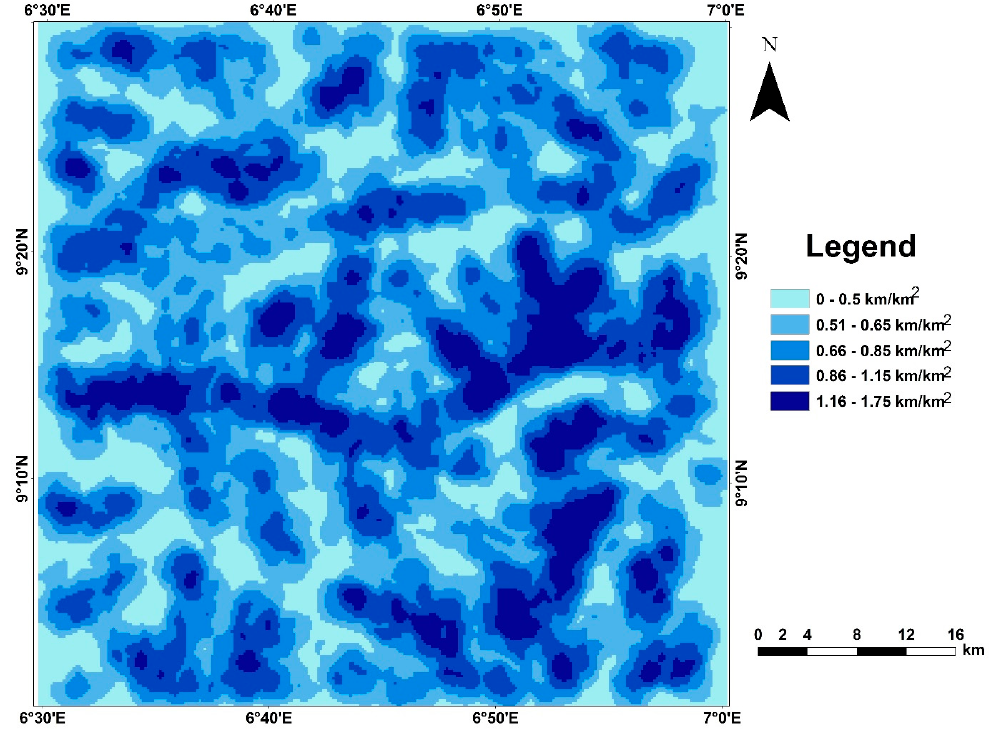
Figure 3. Drainage networks density of Paiko Sheet 185 North Central Nigeria produced from drainage networks extracted from SRTM DEM using density tool of ArcGIS. Areas having lighter shades represent areas of low drainage densities. Drainage density values are inversely proportional to their groundwater recharge potentials.